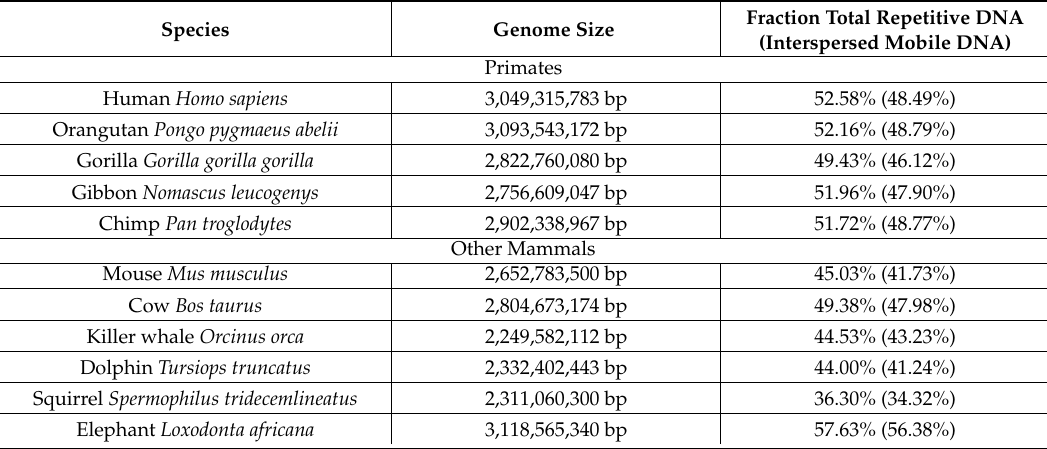
Table 12. Repetitive DNA Content of Some Annotated Animal Genomes (data